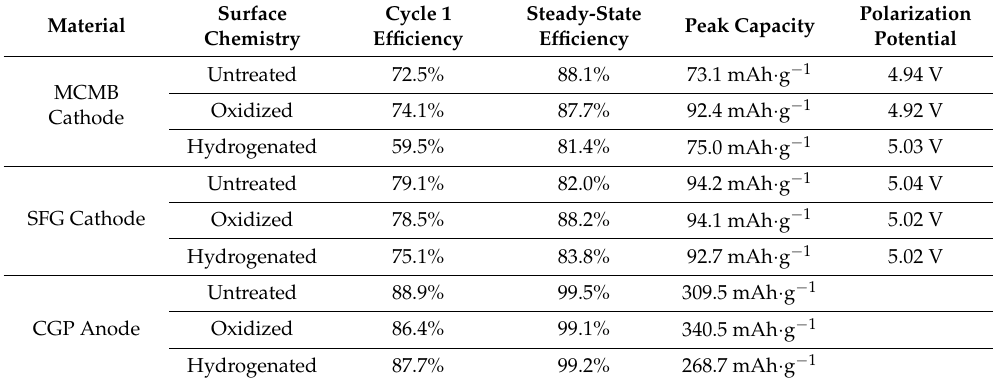
Table 3. First-cycle and steady-state efficiencies, capacities, and polarization potentials of functionalized graphite MCMB and SFG cathodes and ConocoPhillips Graphite Particles (CGP) anodes tested in half-cell configurations.